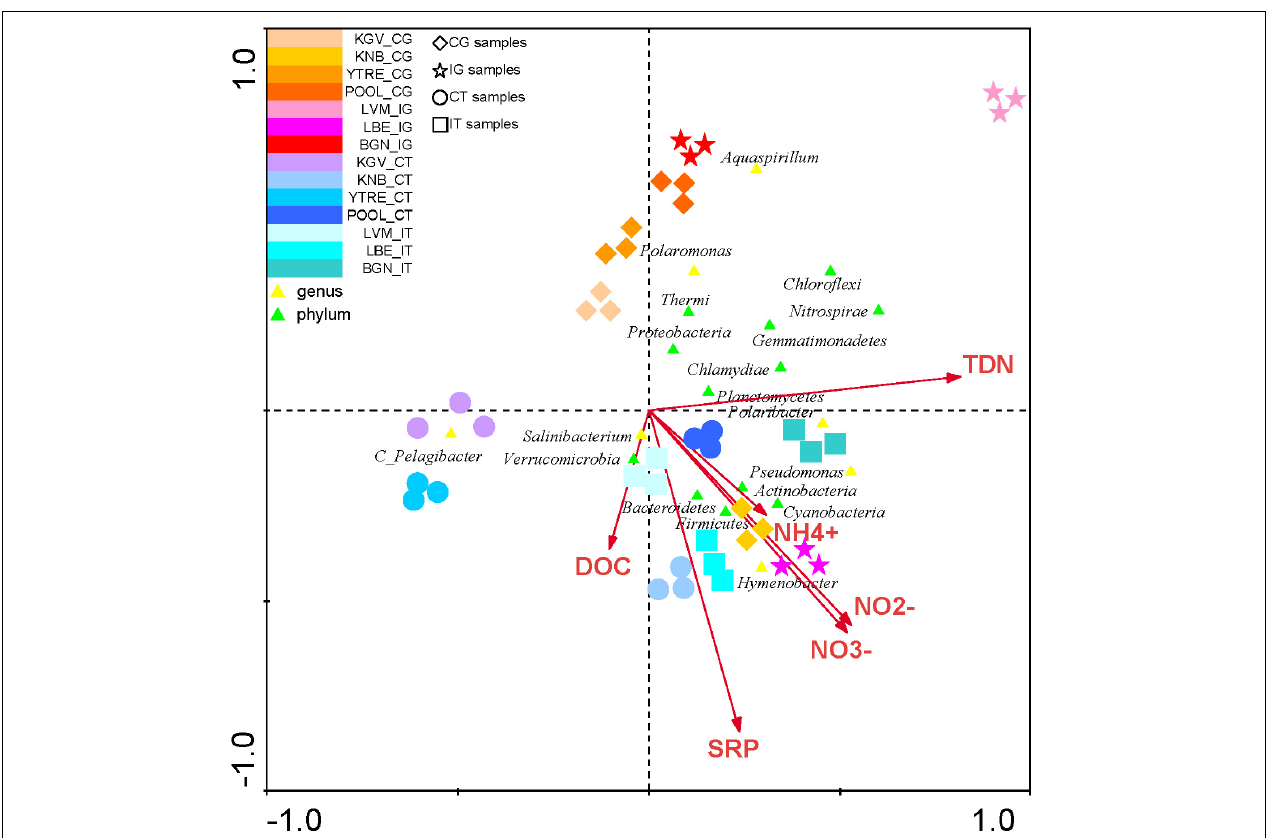
FIGURE 5 | Canonical Correspondence Analysis of the microbial phyla and of the main genus in each sampling site with respect to the concentration of nutrients. The analysis of the bacterial communities with respect to concentration of NH 4 + , NO 2 − , NO 3 − , TDN, SRP, and DOC. The diagram displays triangles that represent taxonomic groups. Sampling sites are represented by different shapes ( : CG samples, ∗ : IG samples, ◦ : CT samples, and (cid:3) : IT samples). Arrows symbolize dissolved nitrogen and phosphorus concentrations. The axes are scaled in standard deviation units. CT, samples from the tidewater area closest to a coastal (cid:51)